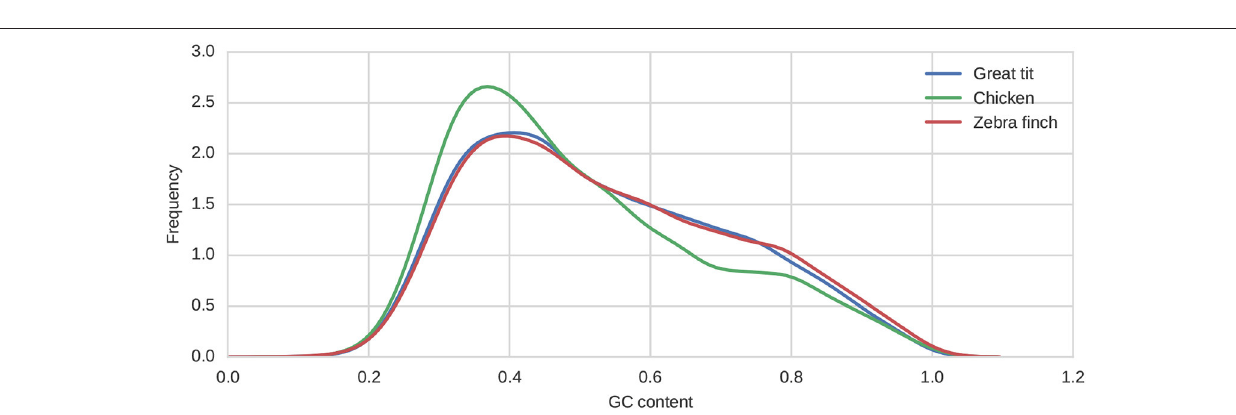
illustrated in Figure 7 for an arbitrary cluster size of 20.